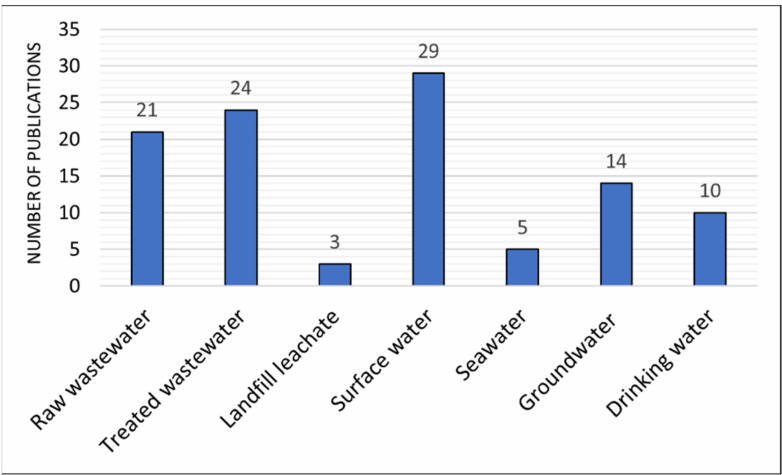
Figure 2. Number of publications of Polish research on PPCPs in water for different types of samples (in the years 2003–2021).